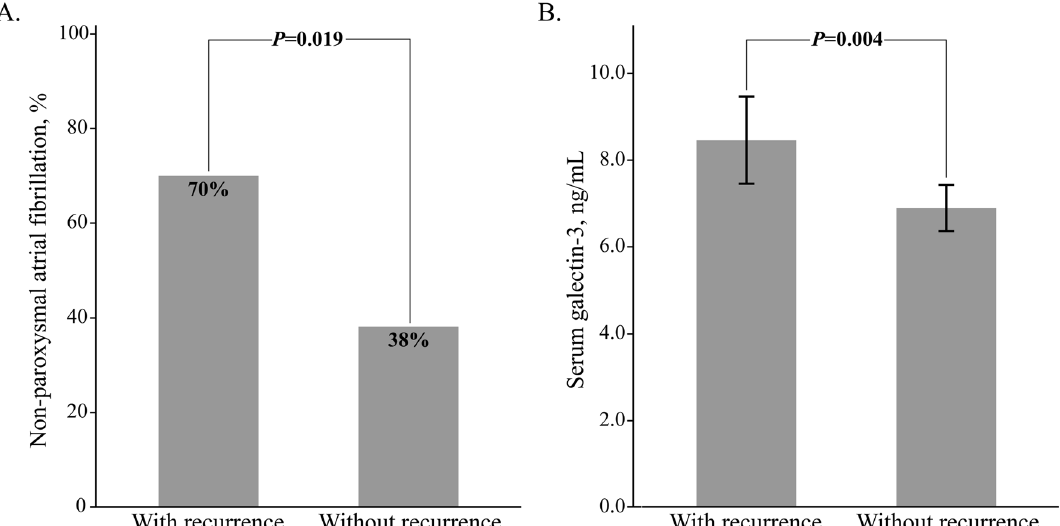
Figure 3. Bar graph comparing clinical factors, based on recurrence. Patients with recurrence showed higher proportions of non-paroxysmal atrial fibrillation ( A ) and higher serum galectin-3 levels ( B ) than patients without recurrence. Values are proportions or means with standard